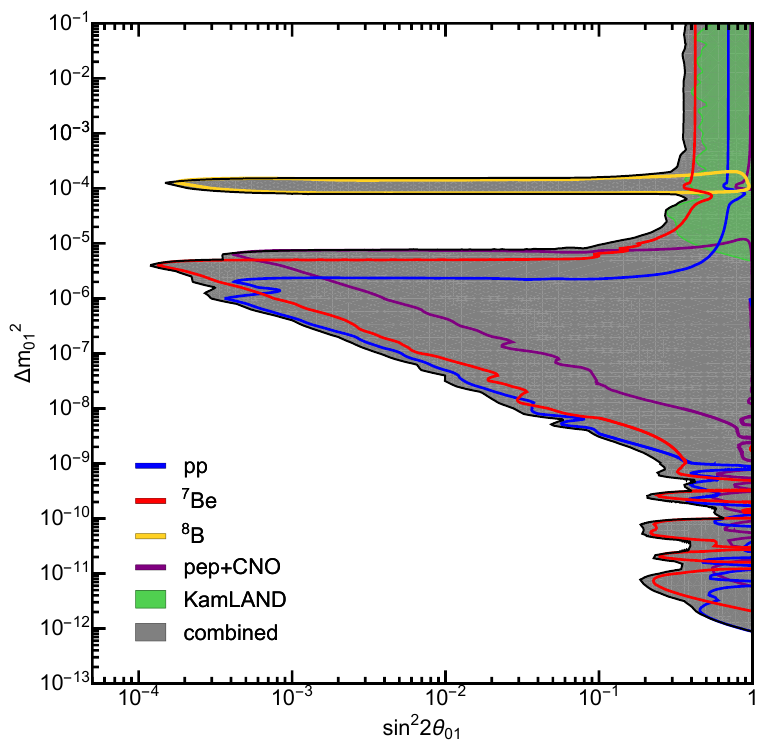
Figure 8 . The 95 % CL bounds on parameters of sterile neutrino in the ( sin 2 2 θ 01 , ∆ m 2 Here we assume only θ 01 is nonzero for the sterile mixing angles. The region enclosed by the blue, red, yellow and purple curves correspond to the exclusion regions obtained by using the pp , 7 Be , 8 B and pep + CNO data at Borexino, respectively. The green and gray shaded regions correspond to the exclusion regions obtained by the KamLAND data alone and combined data of all measurements at Borexino and